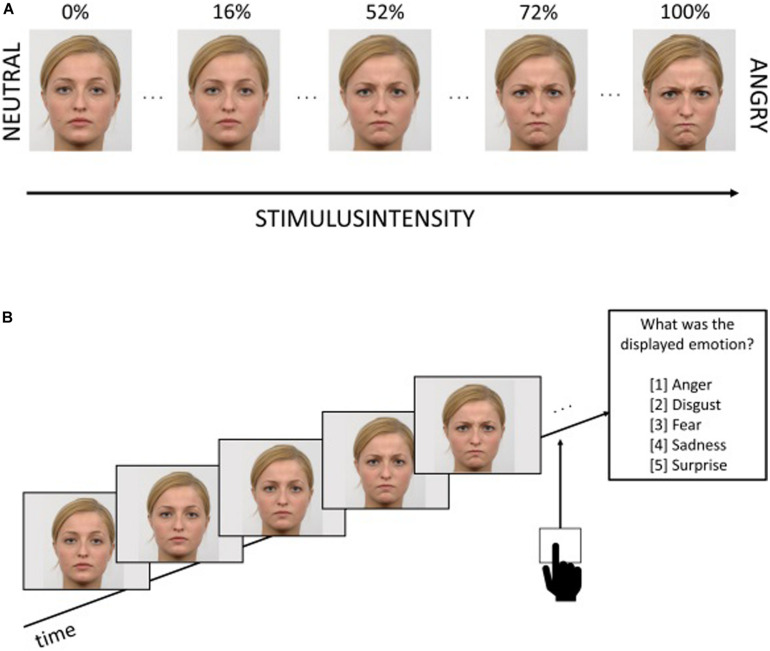
(A) Exampleof the stimuli used in the animated morph task. Stimuli were selected from the Radboud Face Database (Langener et al., 2010). (B) Trial procedure used in the animated morph task in which emotion intensity required until participants responded (i.e., participants sensitivity) and the accuracy of emotion recognition was measured (Schönenberg et al., 2014).